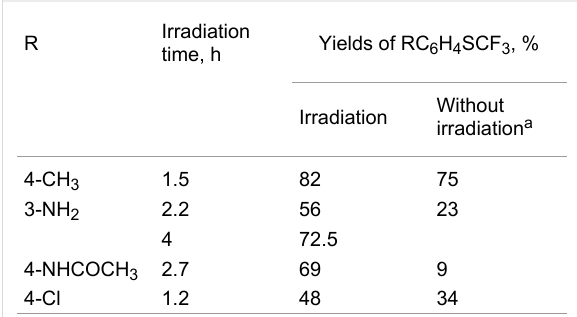
Table 7: Comparison of RC 6 H 4 SCF 3 yields, obtained under a pres- sure of CF 3 Br with and without UV irradiation (DMF, p = 3–5 atm, T = 10–20 °C).